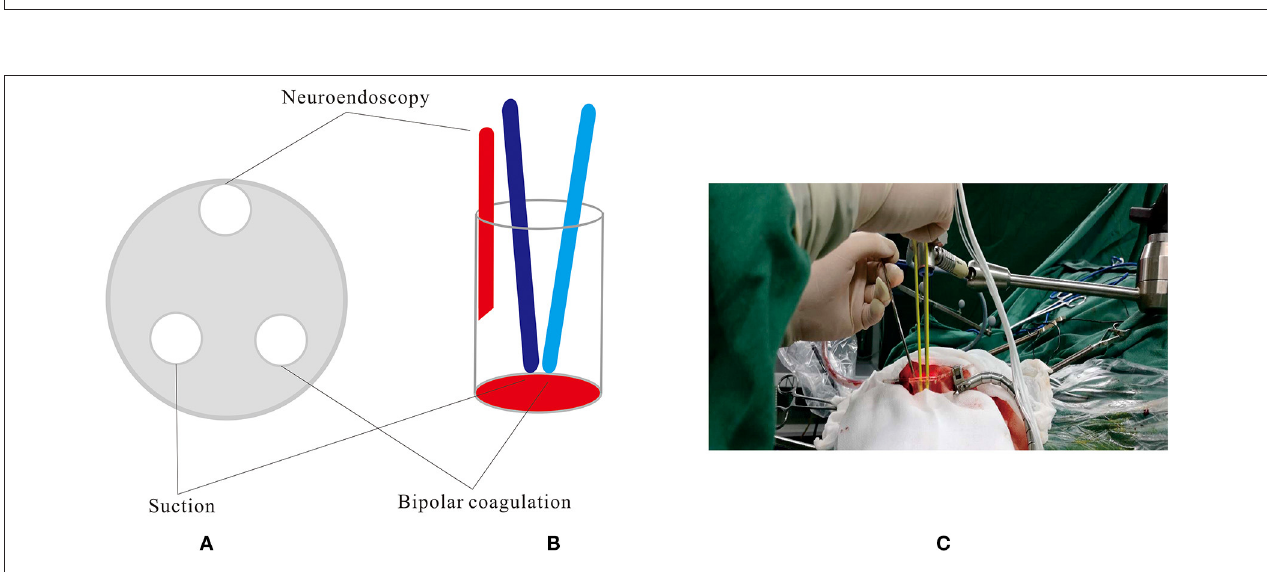
FIGURE 2 | The rigid endoscopy was held by a fixed arm, while a suction and a bipolar coagulation were manipulated by the left and right hand, respectively. (A,B) Schematic diagram. (C) Intra-operative scene.